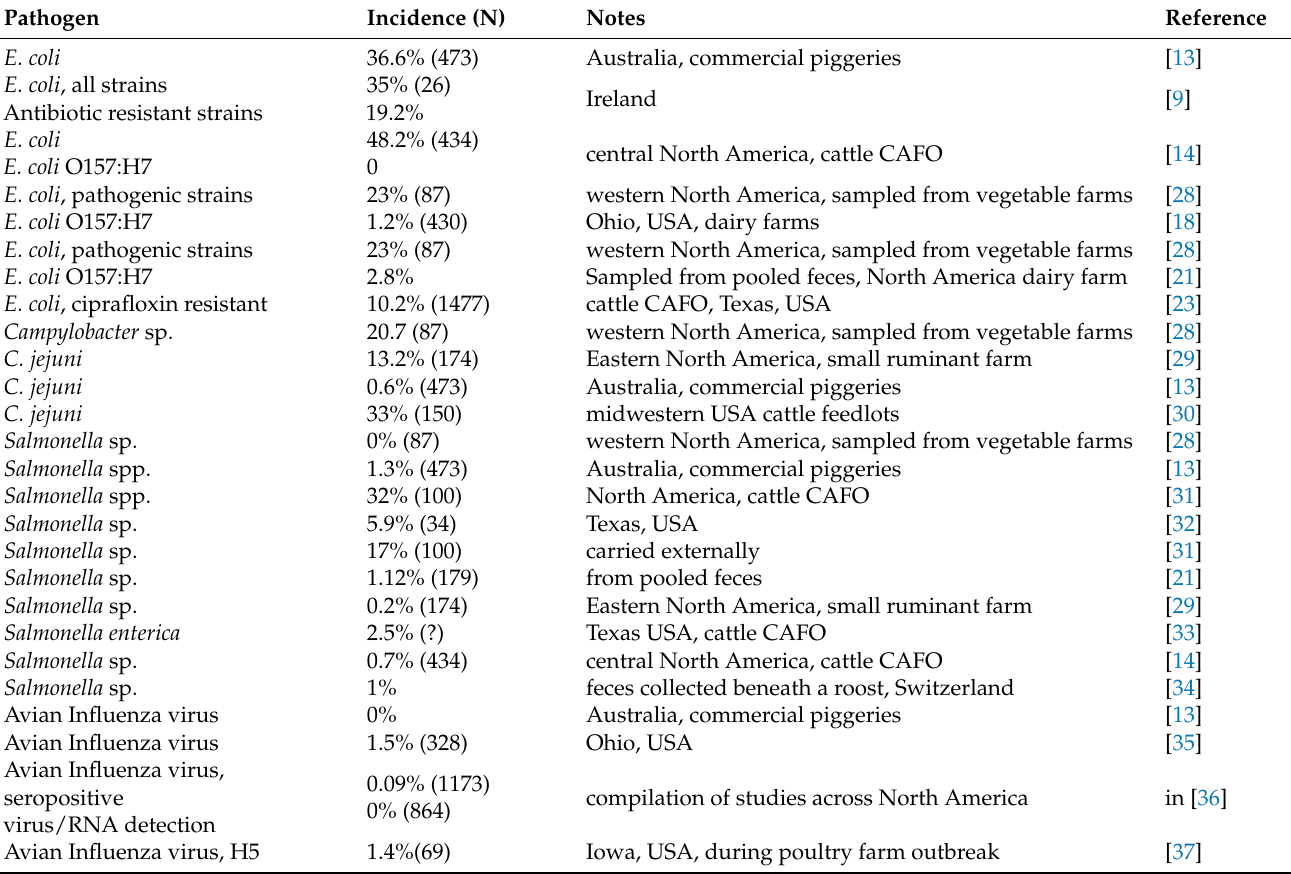
Table 2. Incidence of some pathogens in wild European starlings. Caution is urged in interpreting these data due to the wide variety of research design, methodology, and